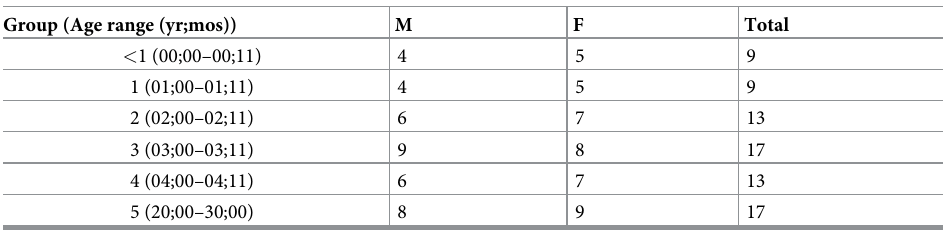
Table 3. Distribution of male and female cases per age group. Group (Age range